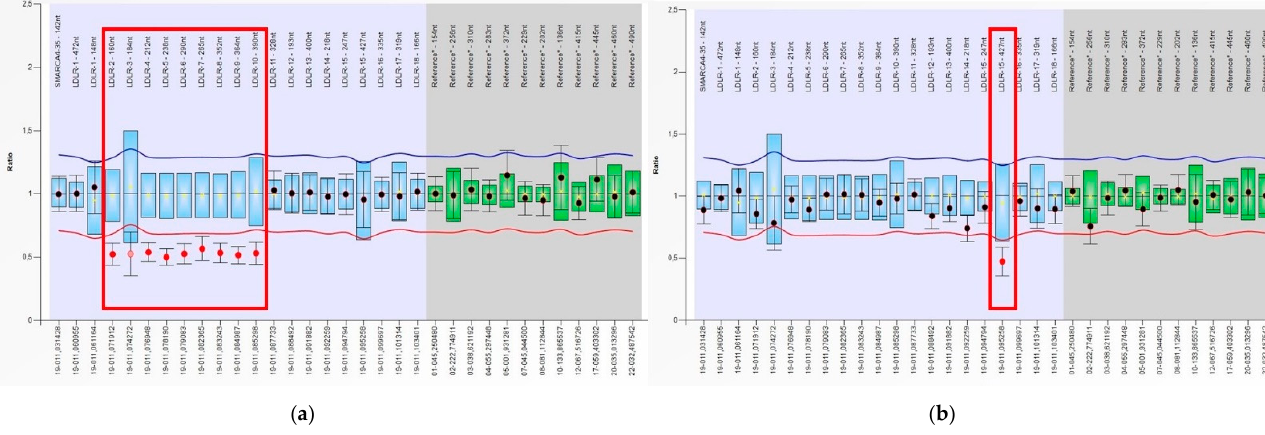
Figure 1. The screened family with variant rs879255191 identified in the LDLR gene.